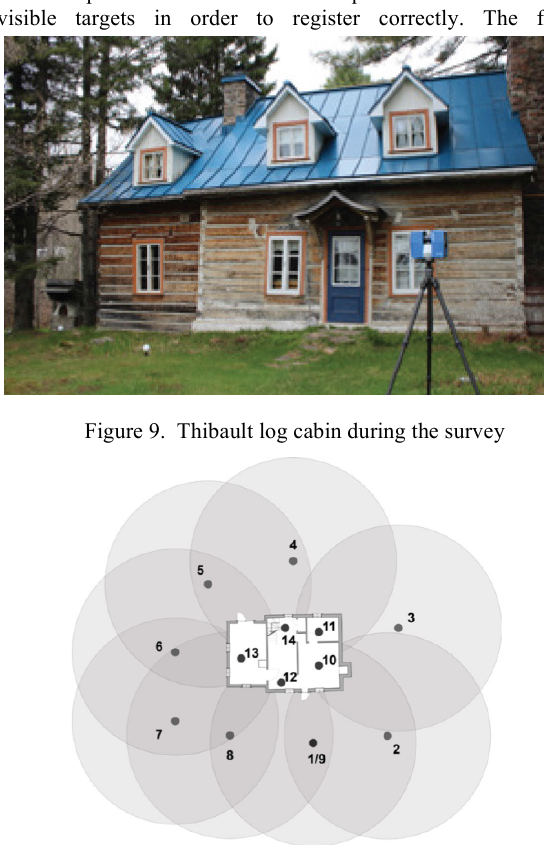
Figure 10. Keyplan showing laser scanner's position during the survey of Thibault log cabin